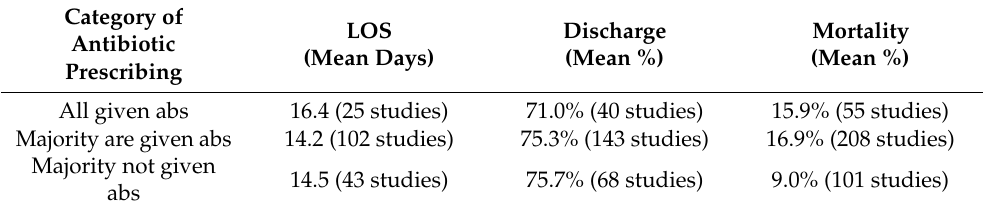
Table 4. Antibiotic prescribing categories and health outcomes in COVID-19